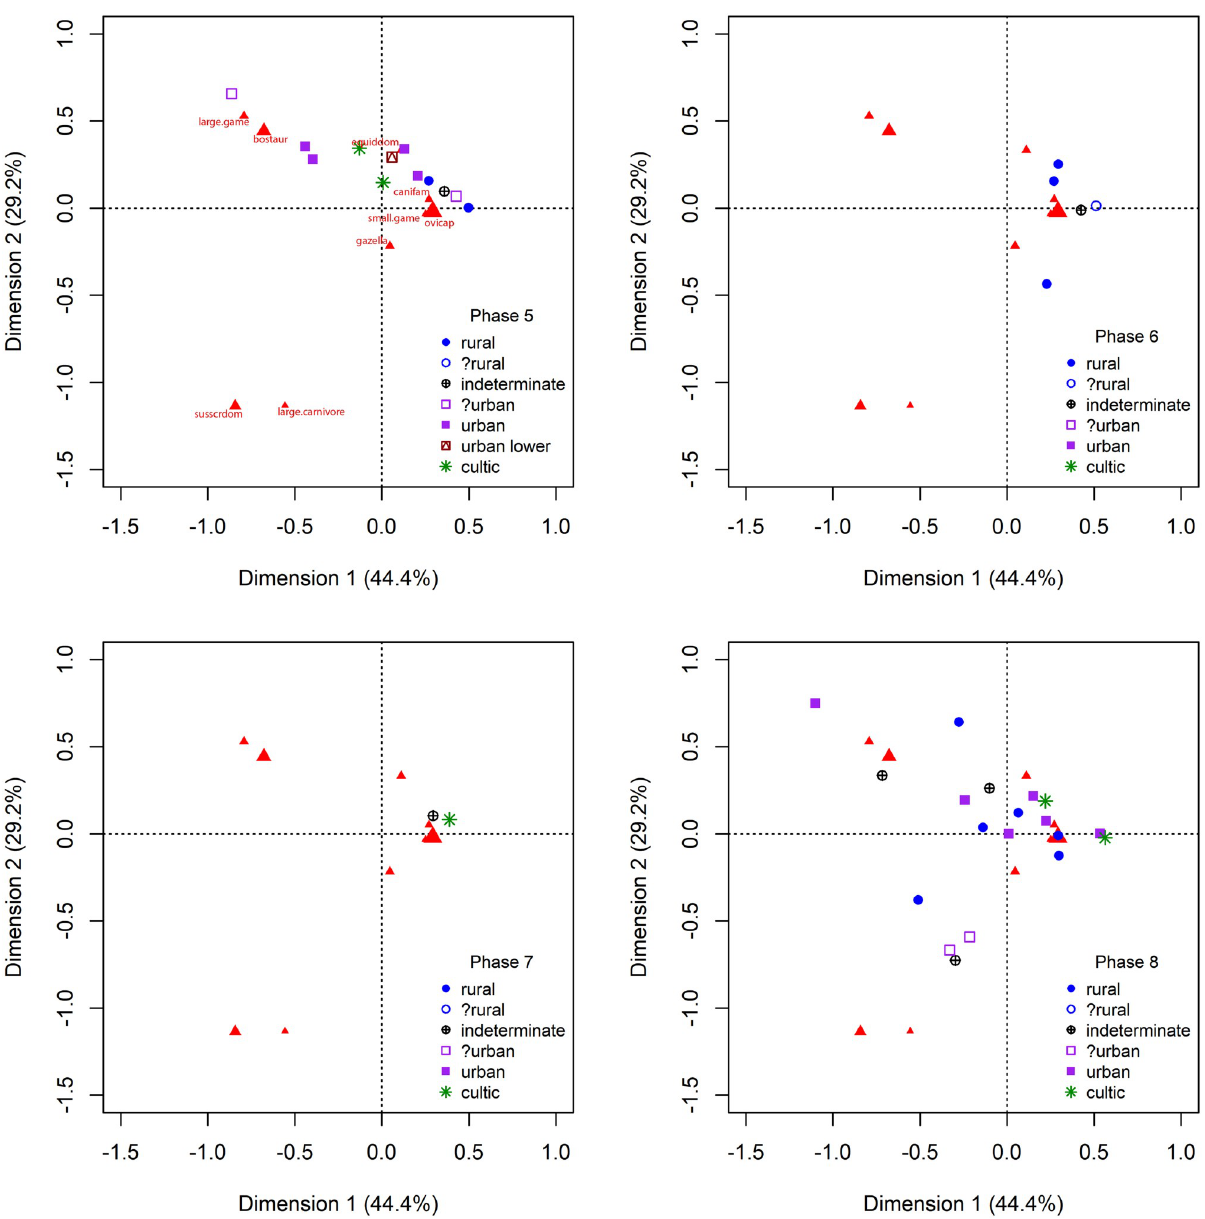
Fig 4. Correspondence analyses of taxonomic distributions for Phases 5 through